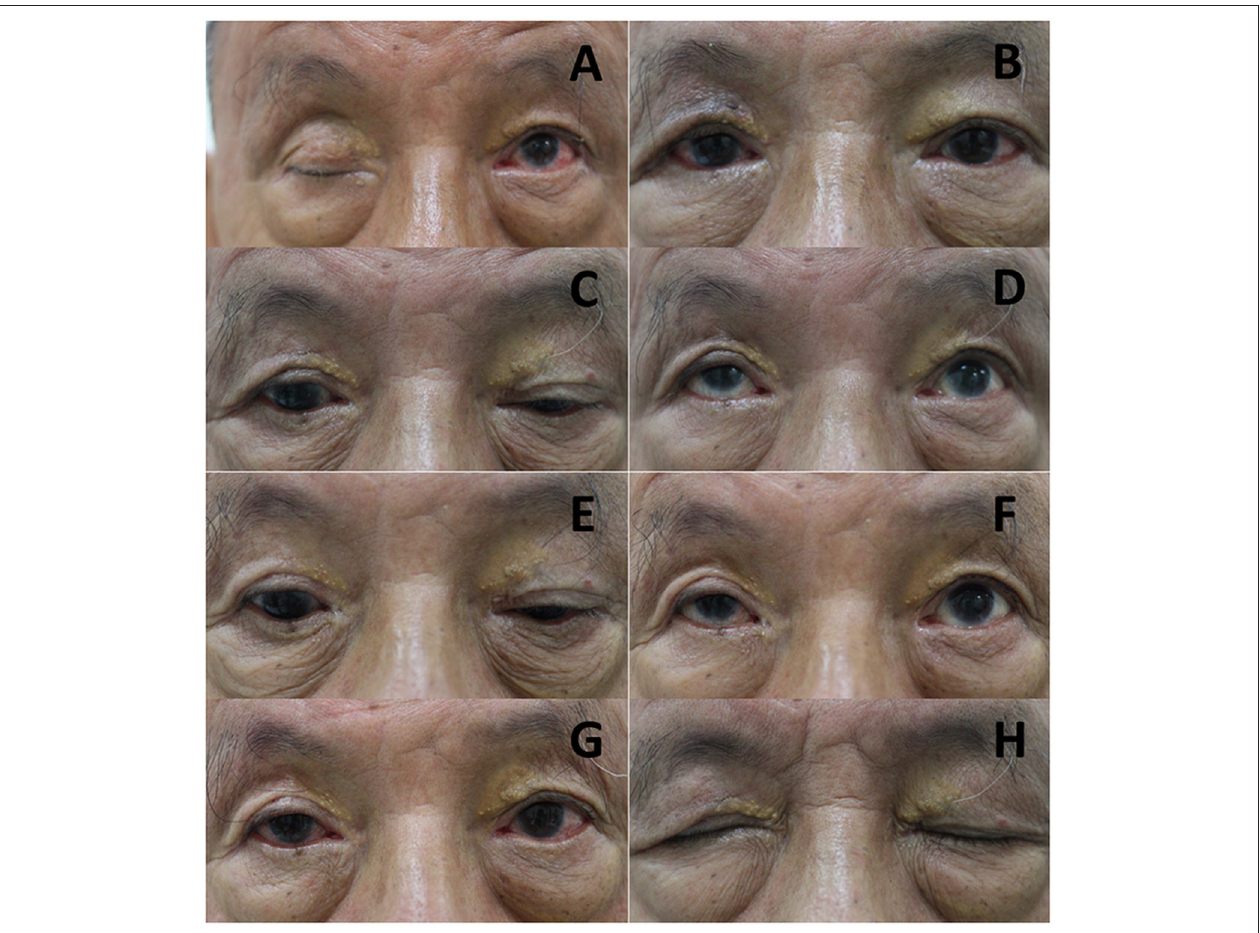
FIGURE 2 | Serial photos of Case 1 before and after frontalis-orbicularis oculi muscle (FOOM) flap shortening surgery and injection of botulinum toxin-A. (A) Photos were taken before and (B) 3 months after FOOM flap shortening, respectively. (C,D) The FOOM flap function (upper eyelid excursion) of the right eye was about 4mm 1 year after FOOM flap shortening. (E,F) The FOOM flap function was reduced to nearly 0mm 1 week after the injection of botulinum toxin-A with 5 units at the central supra-brow area, which was supposed to be the area around the origin of the FOOM flap. (G) 1 week after the injection, he developed blepharoptosis. (H) The patient could close his eyes completely without